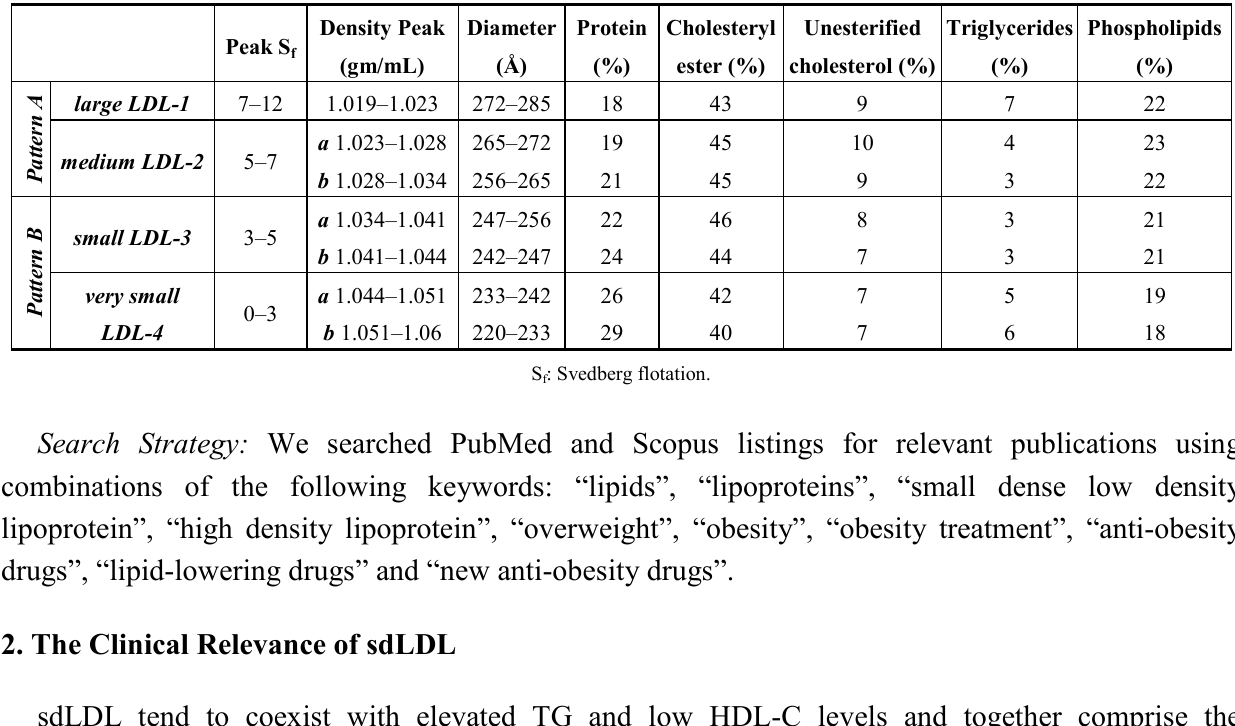
Table 1. Physicochemical properties of low-density lipoprotein (LDL) subclasses (adapted from